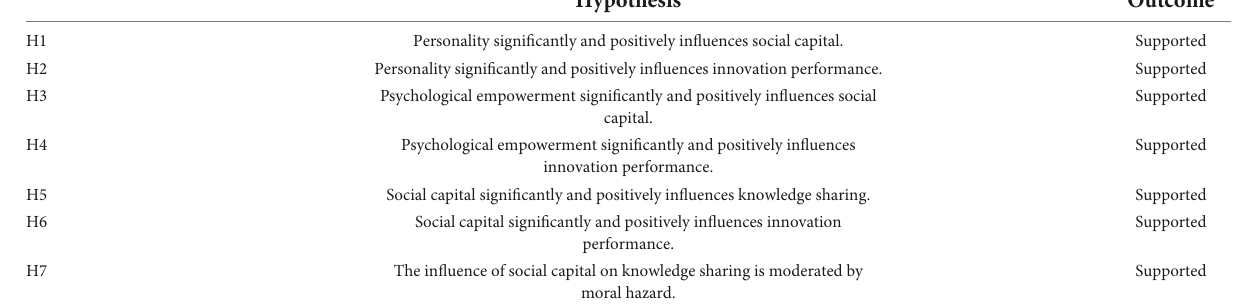
TABLE 8 Summary of the outcomes of hypothesis